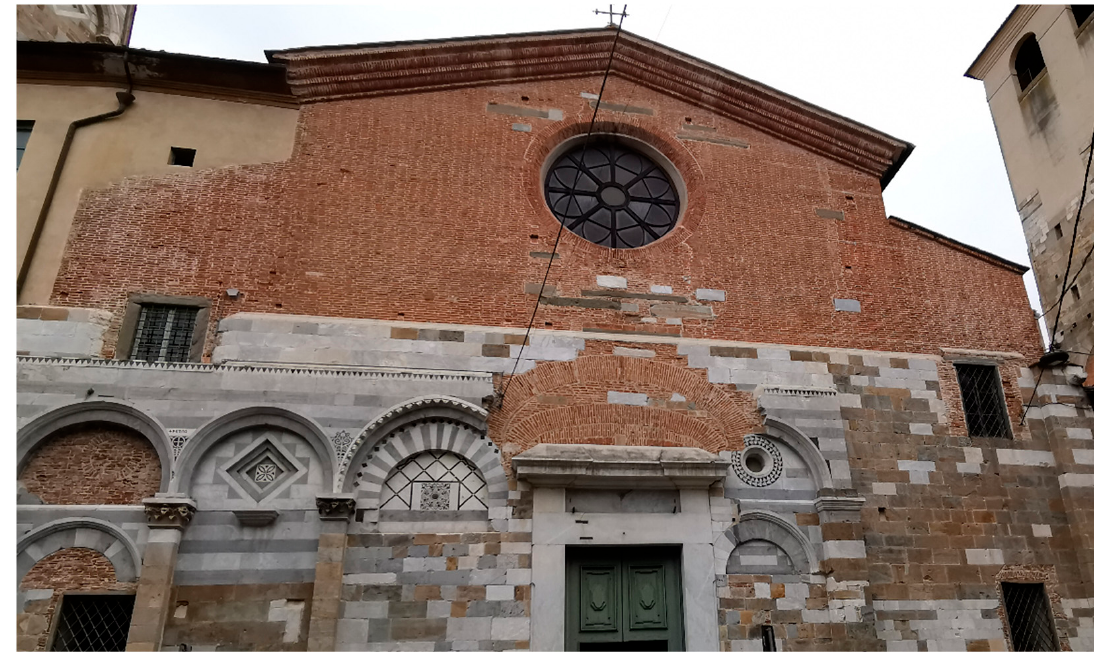
Figure 25. The actual aspect of the main façade—global view (June 2021).